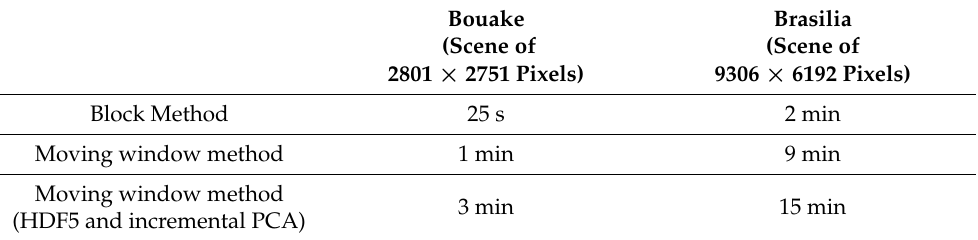
Table 2. Computing time using the FOTOTEX algorithm on Sentinel 2 images over Brasilia (scene of 9306 × 6192 pixels) and Bouake (scene of 2801 × 2751 pixels). Block and Moving window (with or without HDF5 + incremental PCA) methods are compared in this table.